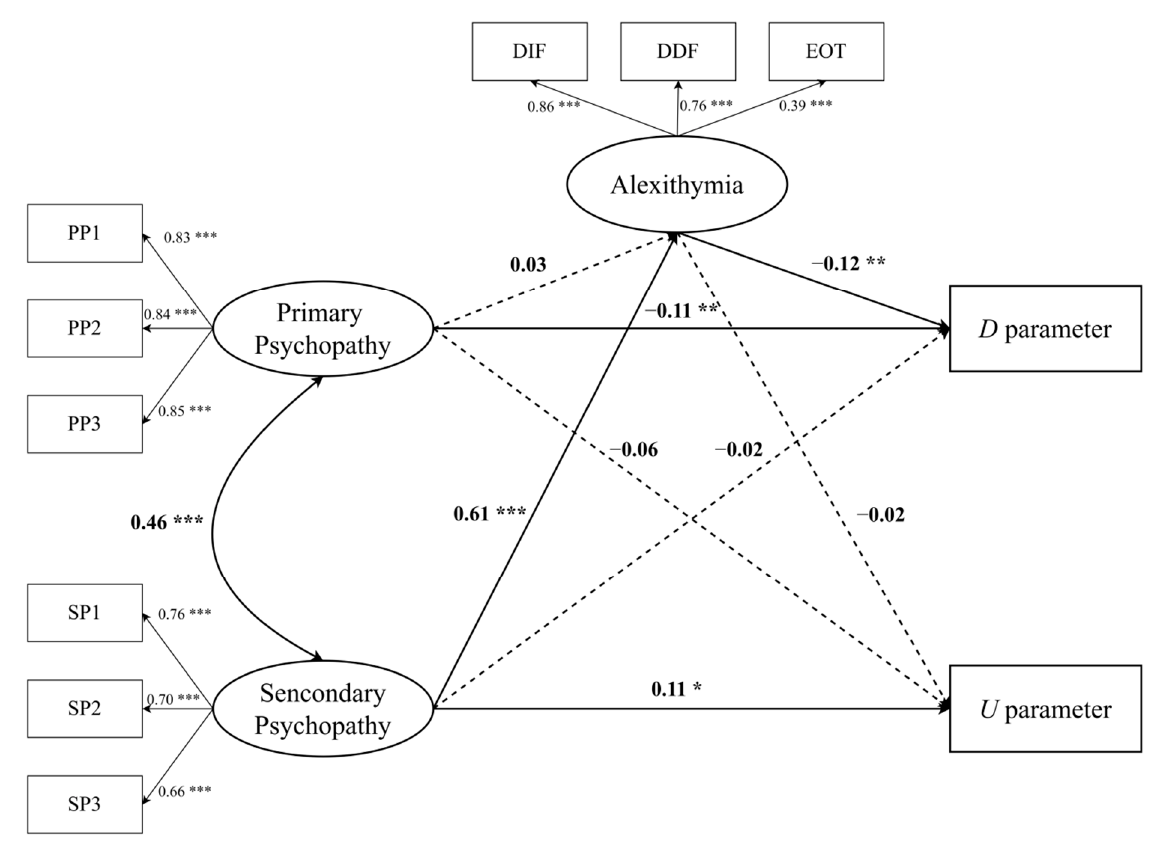
Figure 1. Mediation model from primary and secondary psychopathy to deontological and utilitarian response tendencies. The standardized coefficients are presented above the arrow. PP1, PP2, and PP3 are parcels of primary psychopathy. SP1, SP2, and SP3 are parcels of secondary psychopathy. DIF, DDF, and EOT are dimensions of alexithymia. * p < 0.05; ** p < 0.01; *** p < 0.001.